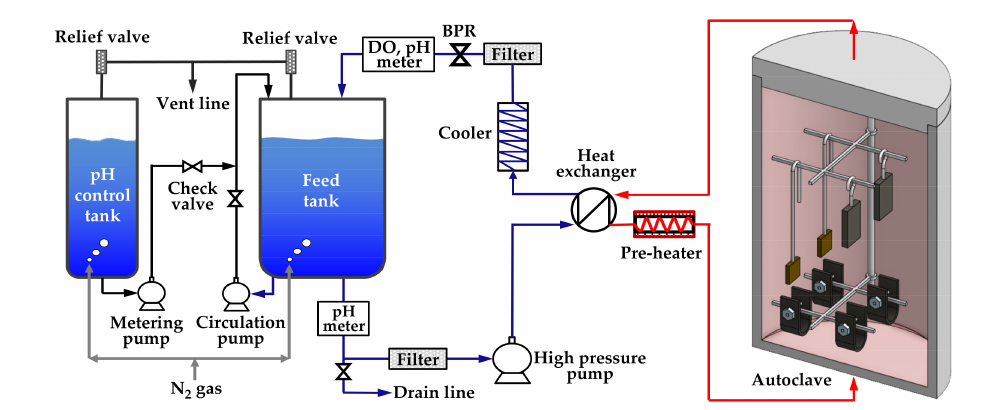
Figure 3. Schematic of the circulating water loop system used for the immersion corrosion